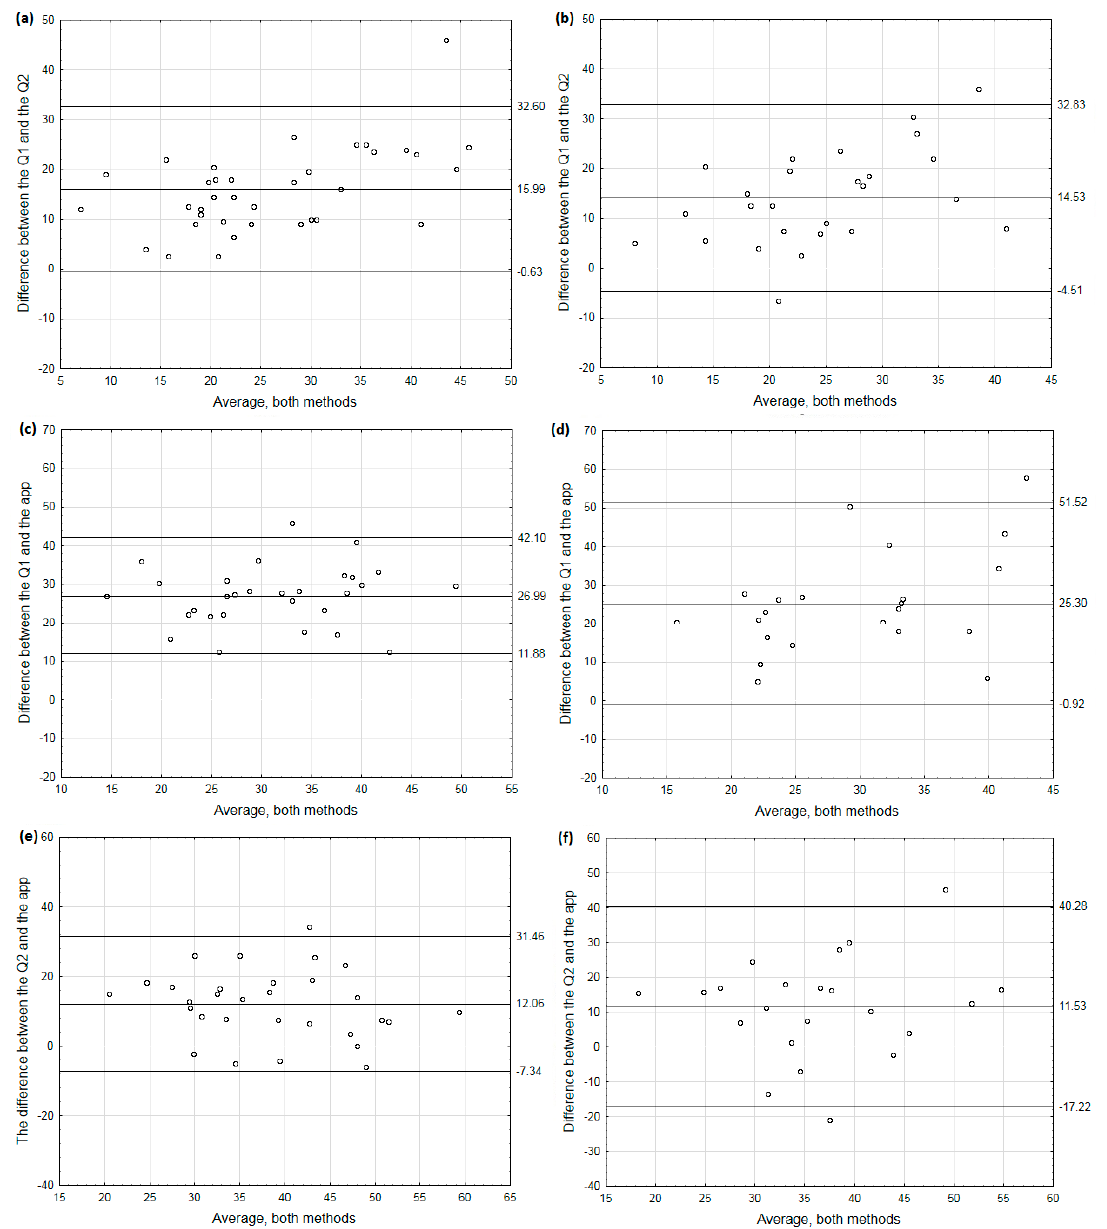
Figure 2. Bland–Altman plots of individual differences between Q1 and Q2, Q1 and the app and Q2 and the app in the normal weight ( a , c , e respectively) and the overweight or obese individuals ( b , d , f , respectively). In case of the app only data from valid responses were considered. Valid responses were those in which respondents gave replies to at least three prompts on at least five days.